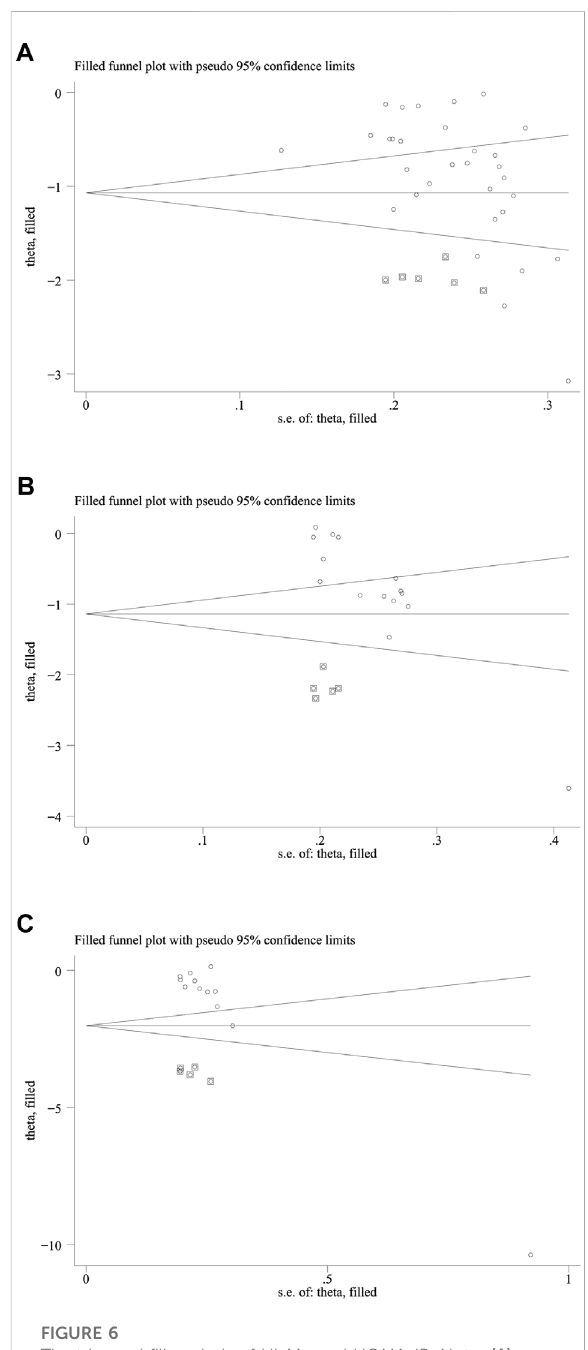
FIGURE 6 The trim and fi ll analysis of HbA1c and HOMA-IR. Note: (A) Represents the trim and fi ll analysis of HbA1c; (B) Represents the trimand fi llanalysisofFINS; (C) Representsthetrimand fi llanalysis of HOMA-IR. The circle represents the actual estimate and the square represents the theoretical estimate when publication bias does not